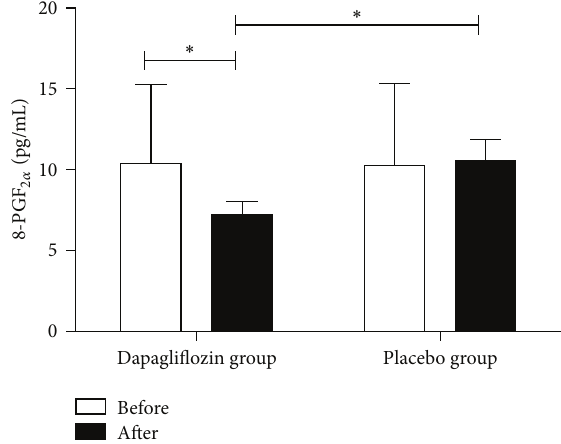
Figure 2: Plasma 8-PGF 2𝛼 levels in T2DM patients before (white bar) and after therapy (black